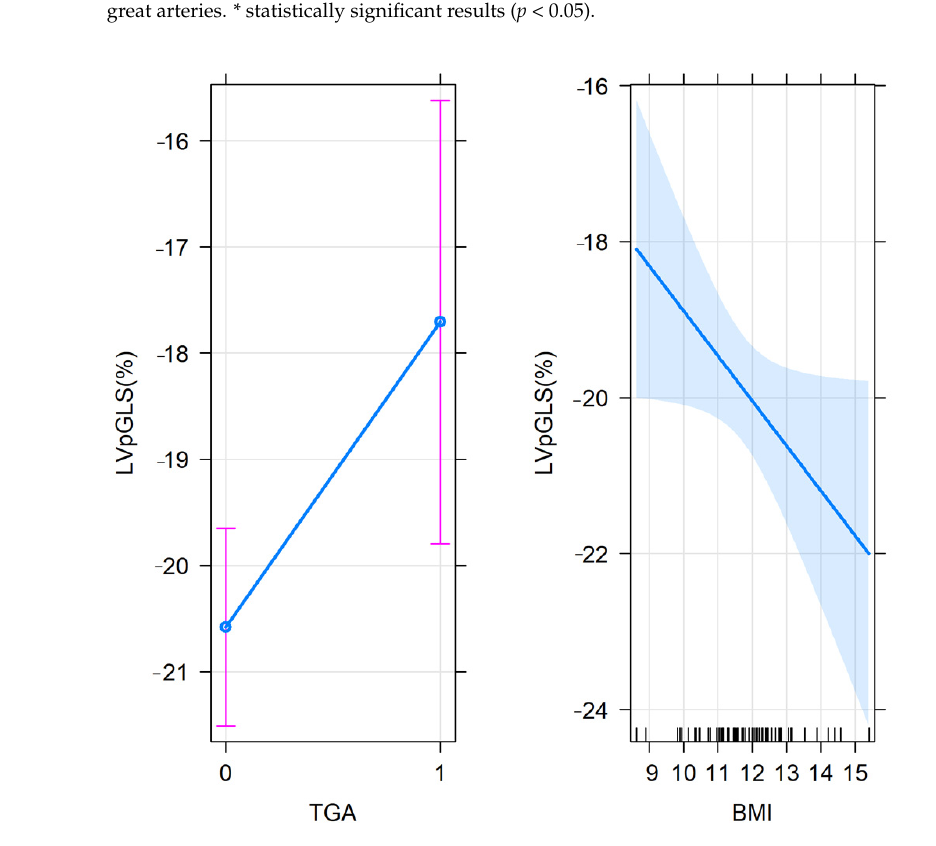
Table 4. Multivariable linear regression model for longitudinal strain measurements (LVpGLS) on overall sample ( n = 66).